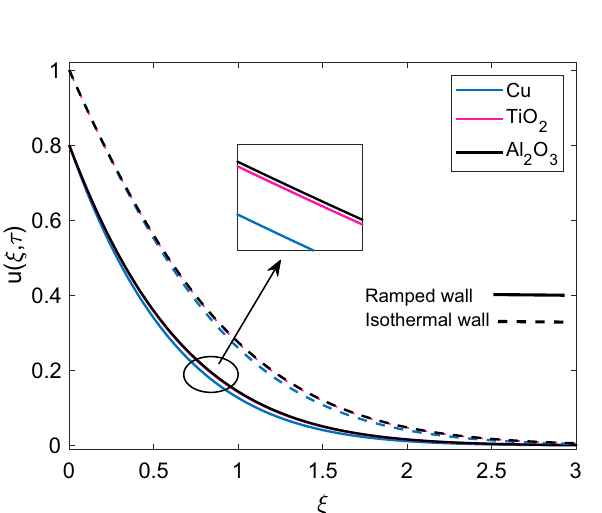
Figure 6. Temperature distribution [Eq. (31)] for various values of τ when Nr = 0.5 , φ = 0.1 and Q = 0.5 .